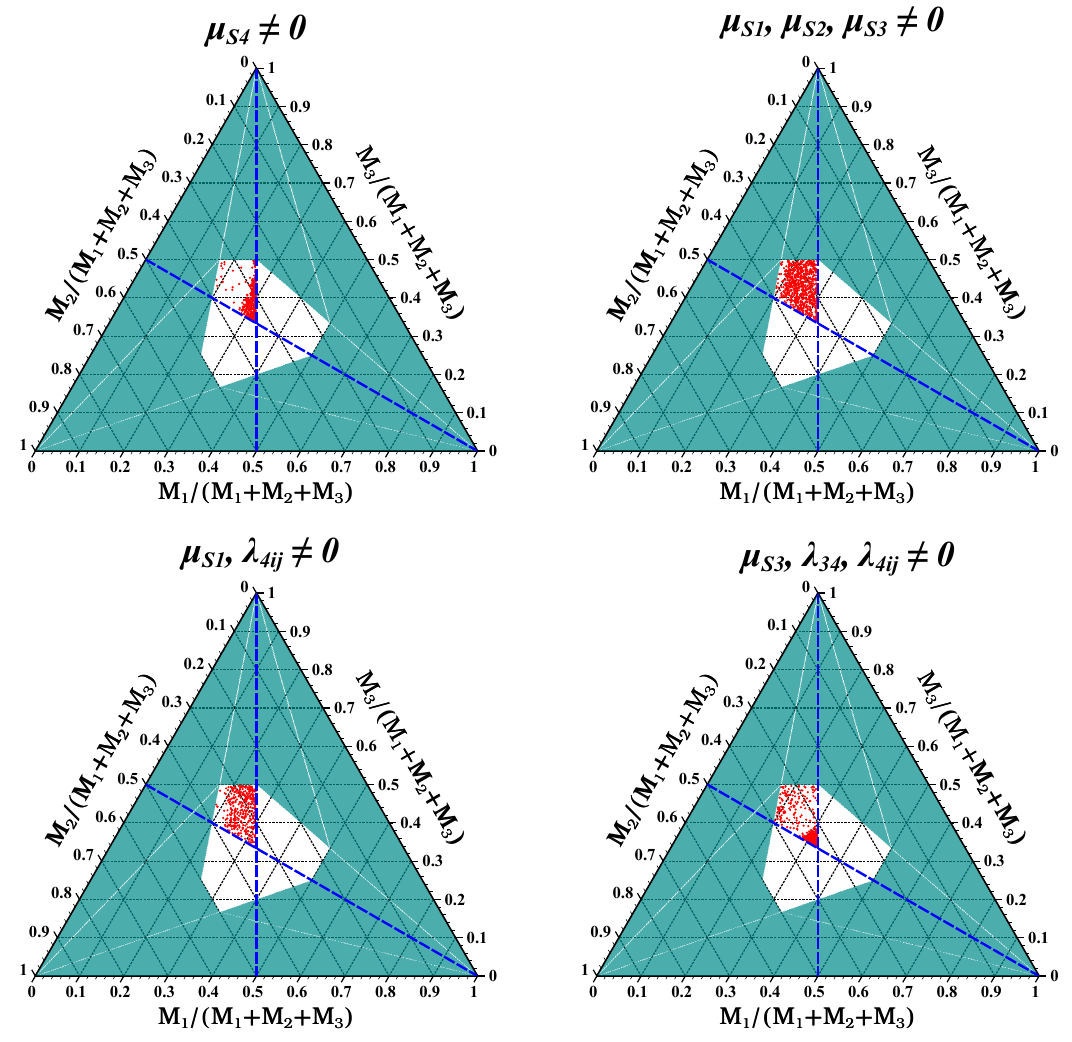
Figure 11 . Ternary plots showing the location of the viable models (red points) for each of the scans analyzed in the previous section. The choice M 1 < M 2 < M 3 restricts the possible location of the points to the top-left region limited by the two dashed